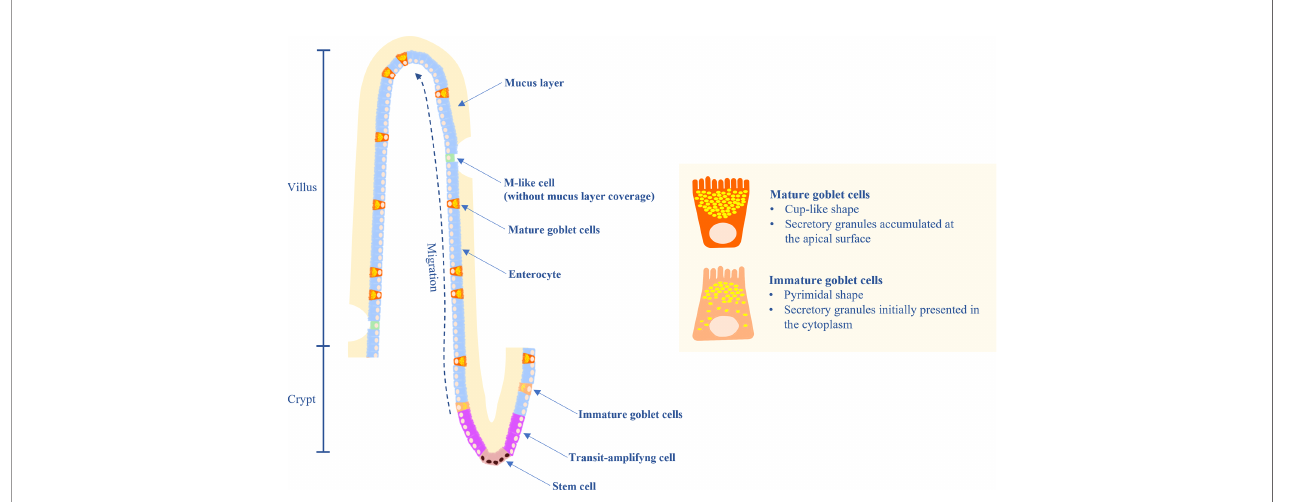
FIGURE 1 | Diagram of the small intestinal epithelium highlighting the characteristics of immature and mature goblet cells (GC), GC migration, and mucus